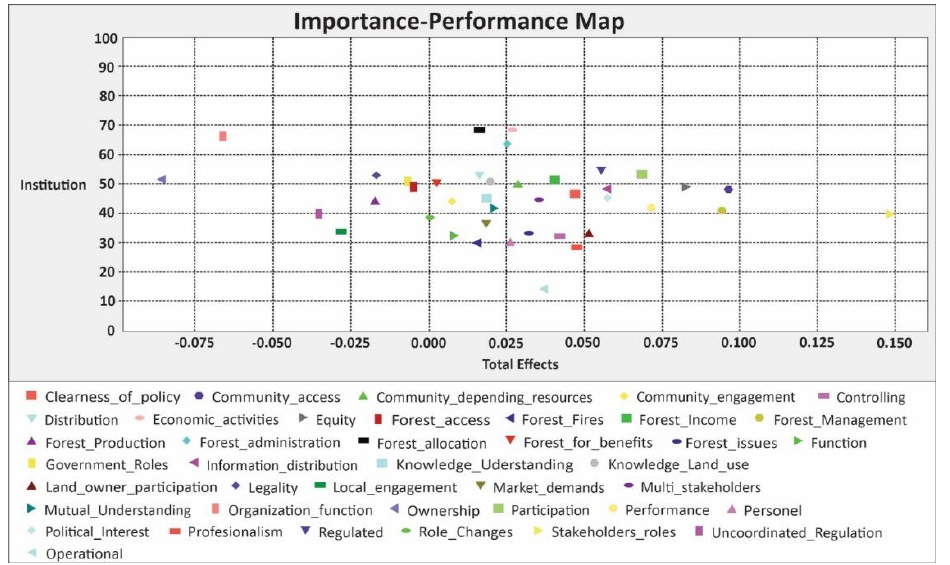
Figure 4. Scatter plot of correlations between local institutions and the indicators’ variables in the Bengkalis regency (source: analysed and visualised with SmartPLS 2020).